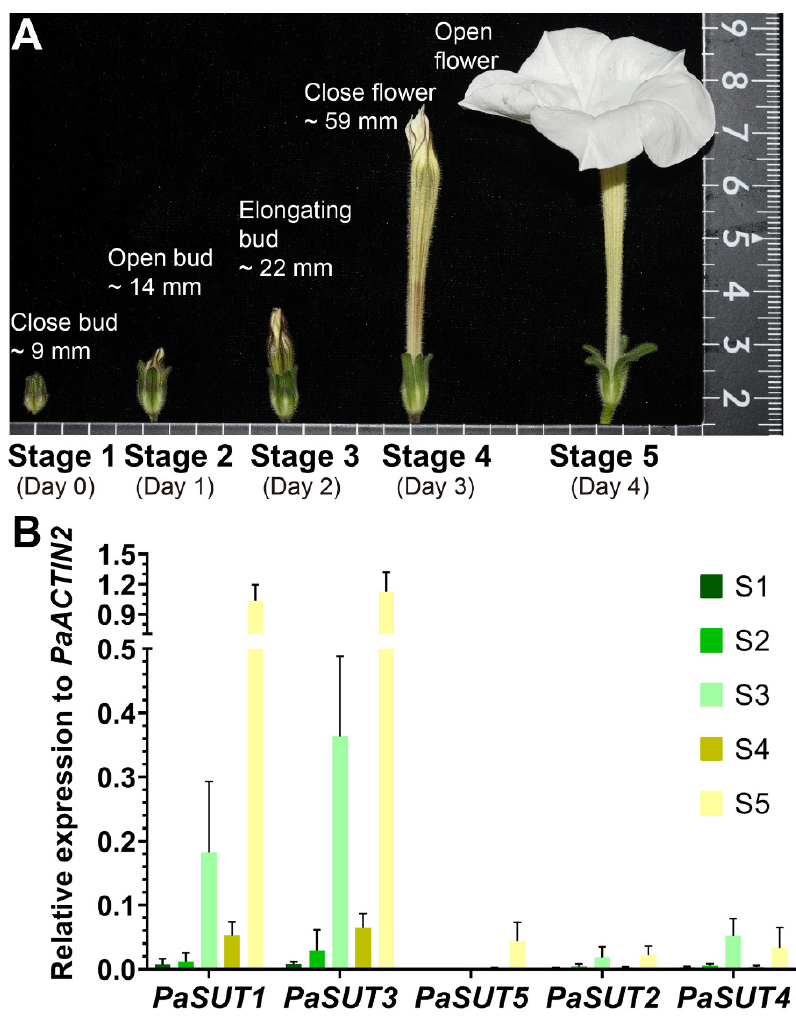
Figure 3. The P. axillaris flower developmental stages ( A ) and expression profile of the five PaSUT genes ( B ). Data represent mean and SD of three independent determinations, each is a pooled sample with 2-5 flowers.